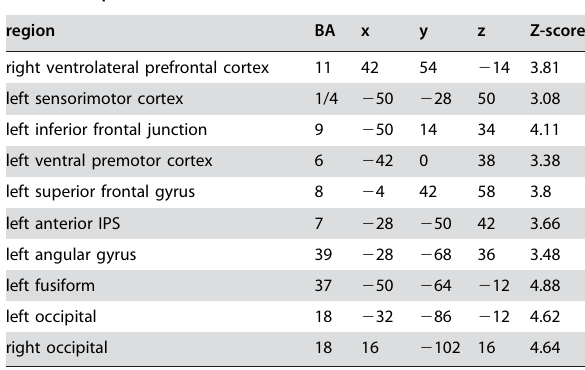
Photo conceptual .